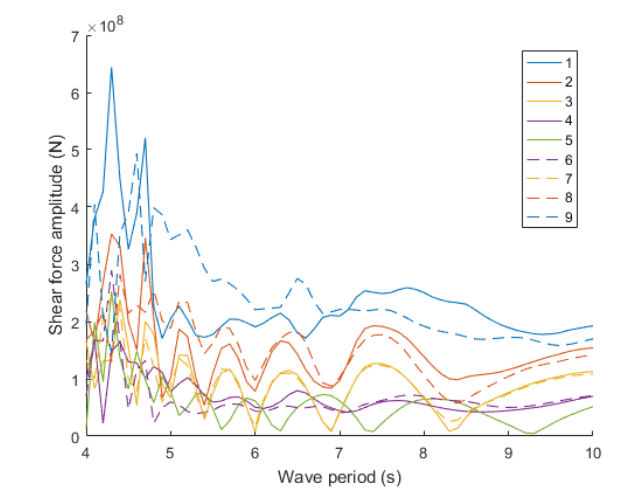
Fig. 14. Shear forces in the heave direction at each of the nine spine joints, in a wave heading of 40°. Joints are numbered from fore to aft (see legend).